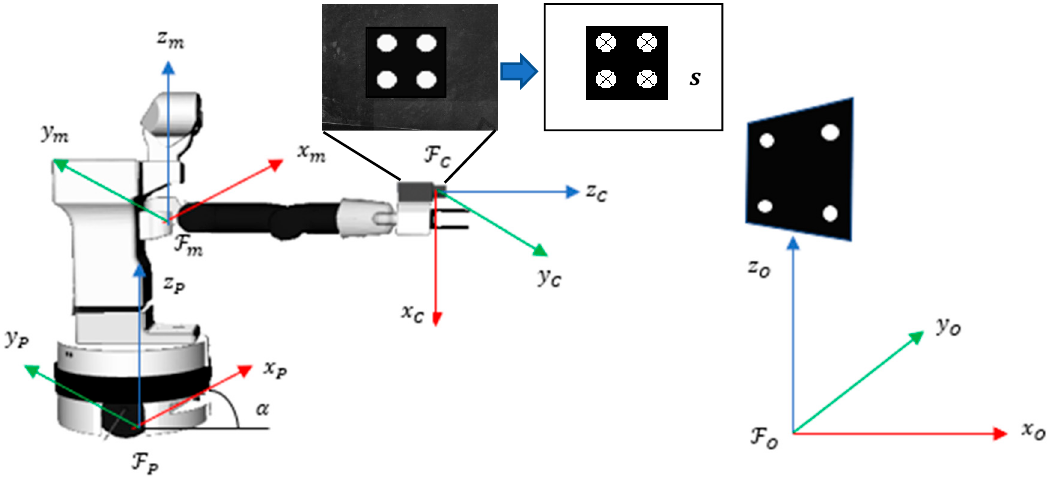
Figure 1. System components.